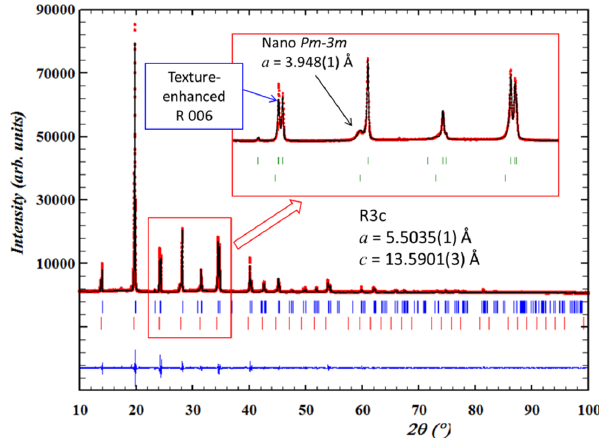
Figure 21. Synchrotron X-ray diffraction pattern and Rietveld analysis of a hot-pressed and recrystallized BNBT6 ceramic flat specimen after poling with electric field perpendicular to the explored surface. Reliability factors: R p = 5.63, R wp = 8.06. Inset shows some relevant peaks of the ceramic perovskite structure consisting on a rhombohedral R 3 c symmetry and a nanosized cubic symmetry, associated with the humps that appear at the low angle side of the main perovskite